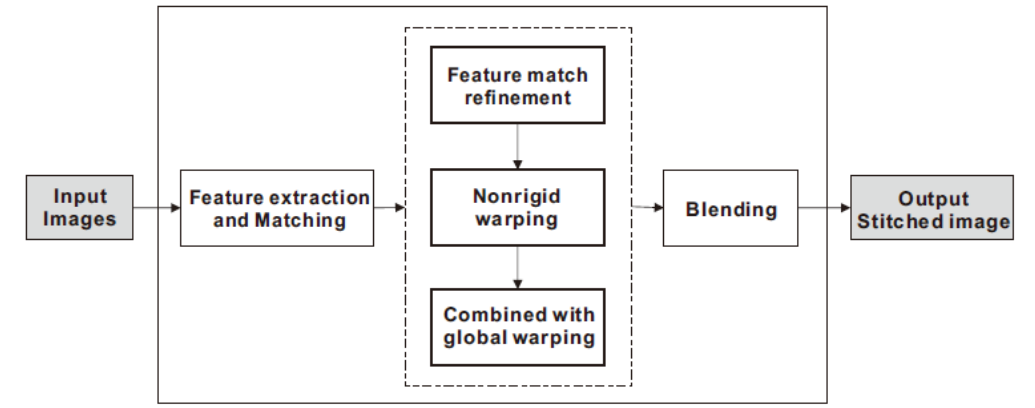
Figure 1. The overview flowchart of our proposed image stitching